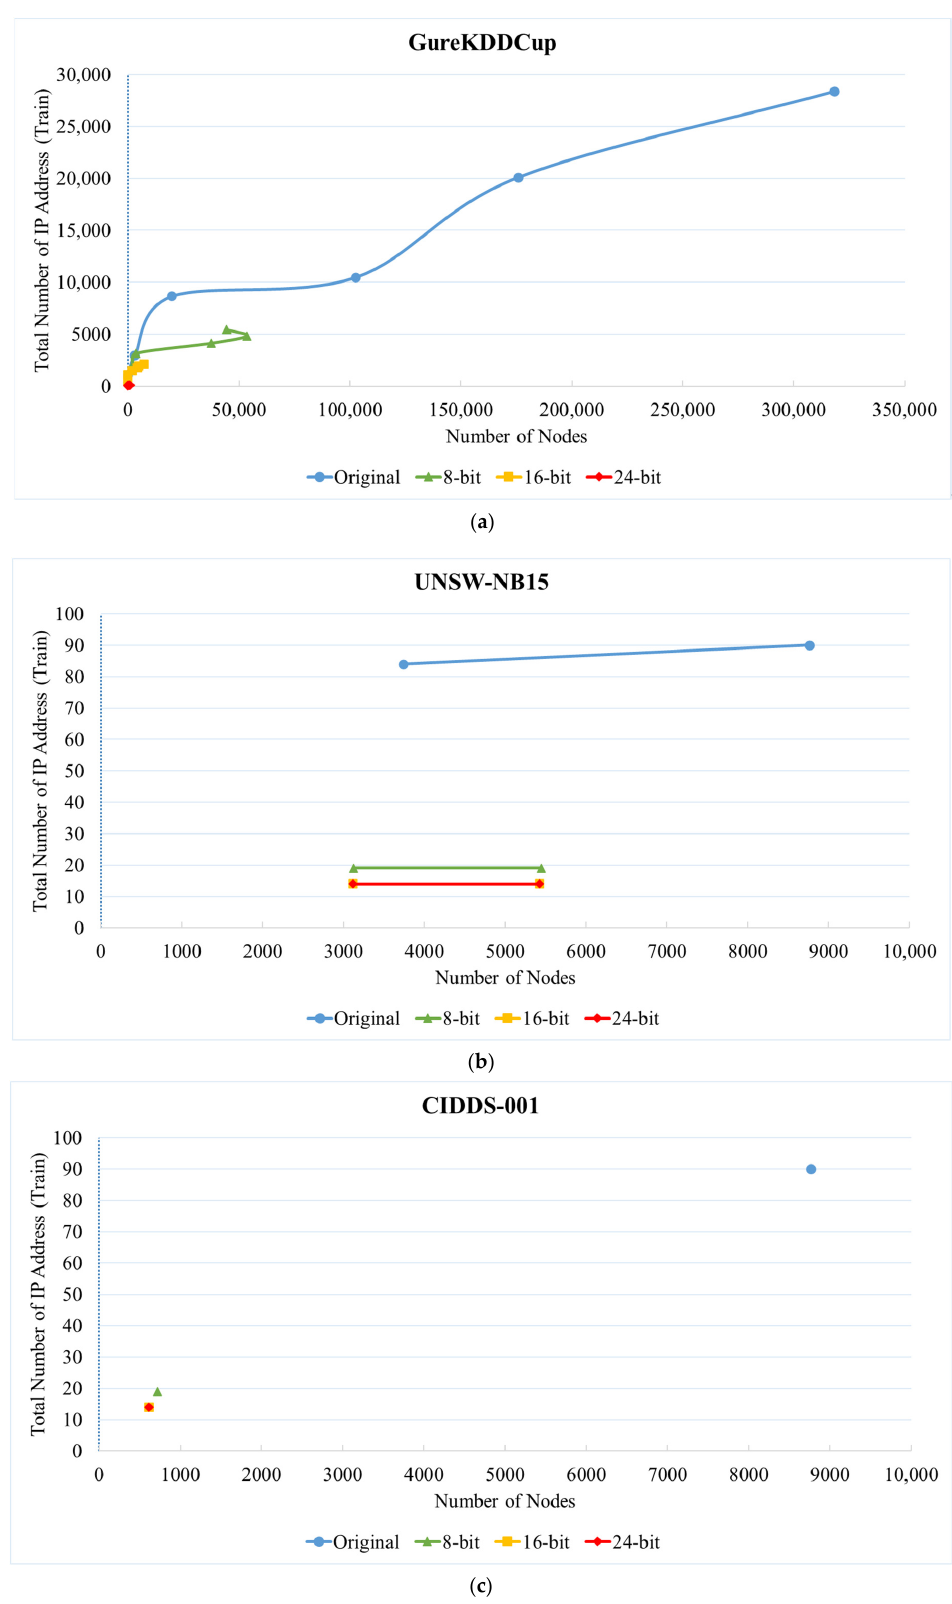
Figure 6. Total Number of IP Addresses in the Training Set ( Y ‐ axis) Versus the Number of Nodes ( X ‐ axis) in ( a ) GureKDDCup’99, ( b ) UNSW ‐ NB15, ( c ) CIDDS ‐ 001.